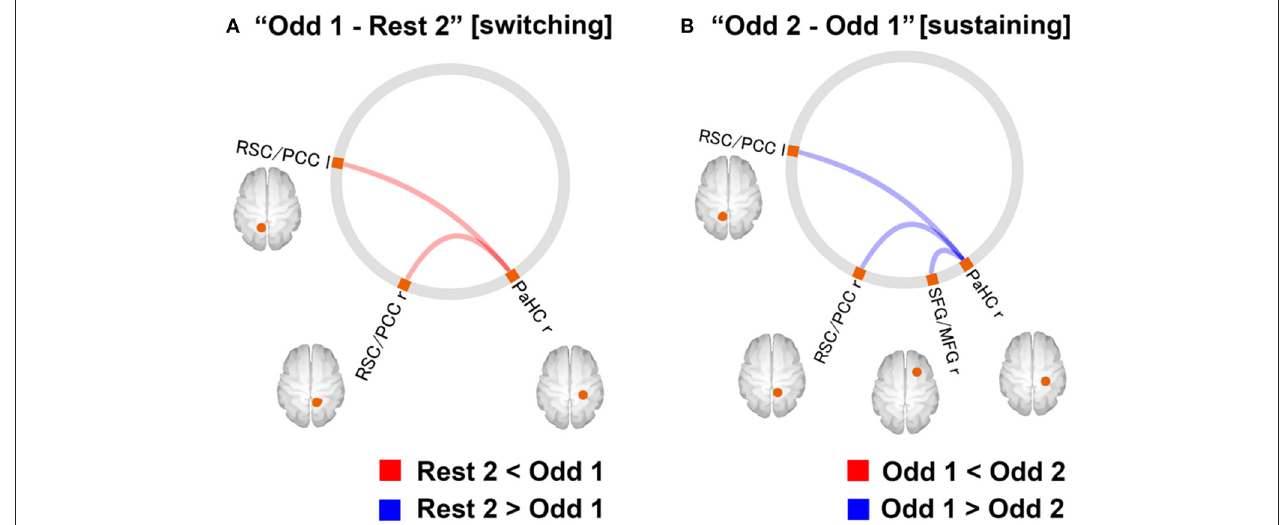
FIGURE 7 | (A) Changes in DMN-FC at “switching” phase. The red line indicates that the FC values for the “Odd 1” period were significantly higher than those for the “Rest 2” period. (B) FCs with a significant difference at “sustaining” phase. The blue line indicates that the FC values for the “Odd 2” period were significantly lower than those for the “Odd 1” period (statistical threshold, FDR corrected, p < 0.05). FC, functional connectivity; FDR, false discovery rate; DMN, default mode network; r, right; l, left; PCC, posterior cingulate cortex; RSC, retrosplenial cortex; SFG, superior frontal gyrus; MFG, middle frontal gyrus; PaHC, parahippocampal cortex [Revised from Miyagi et al. ( 60)].